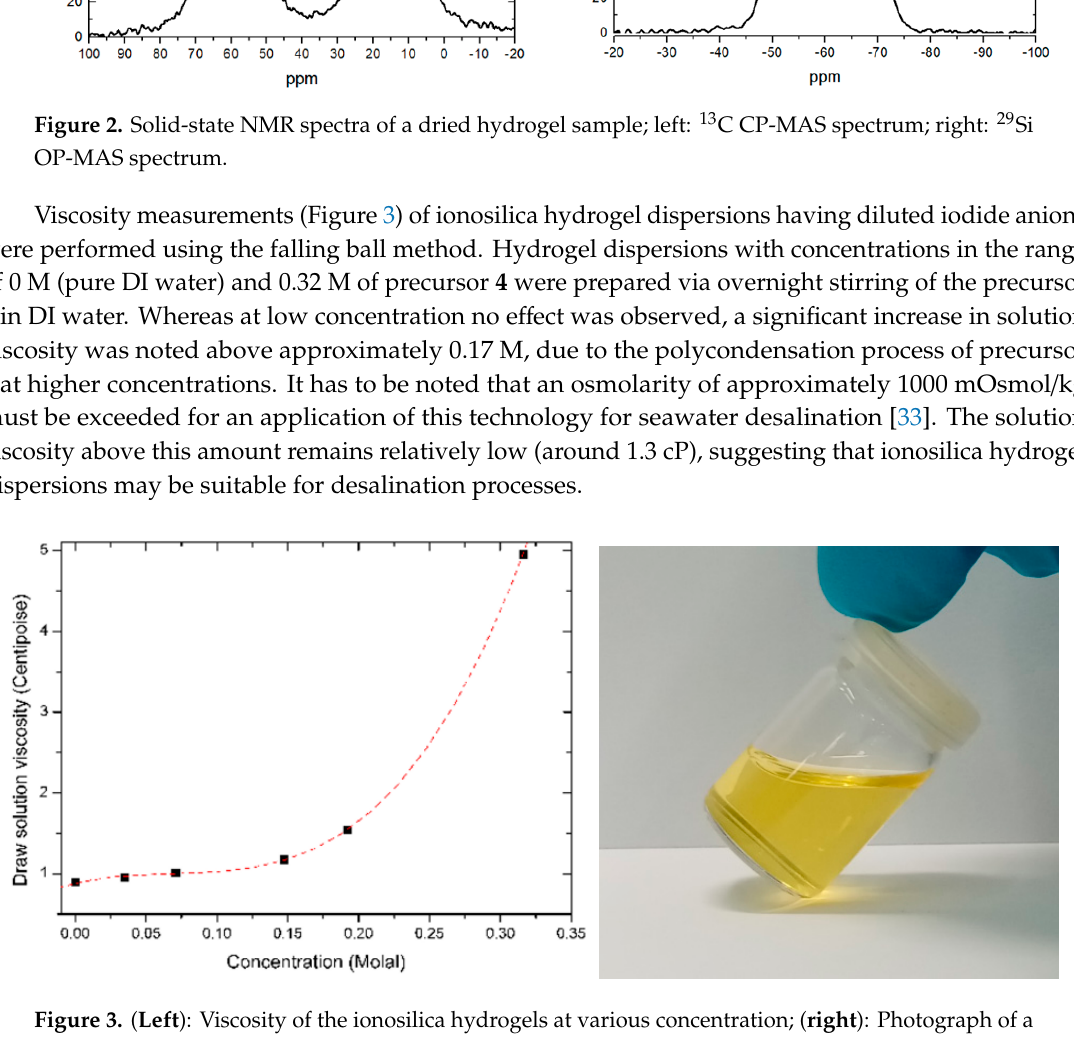
Figure 2. Solid-state NMR spectra of a dried hydrogel sample; left: 13 C CP-MAS spectrum; right: 29 Si OP-MAS spectrum.